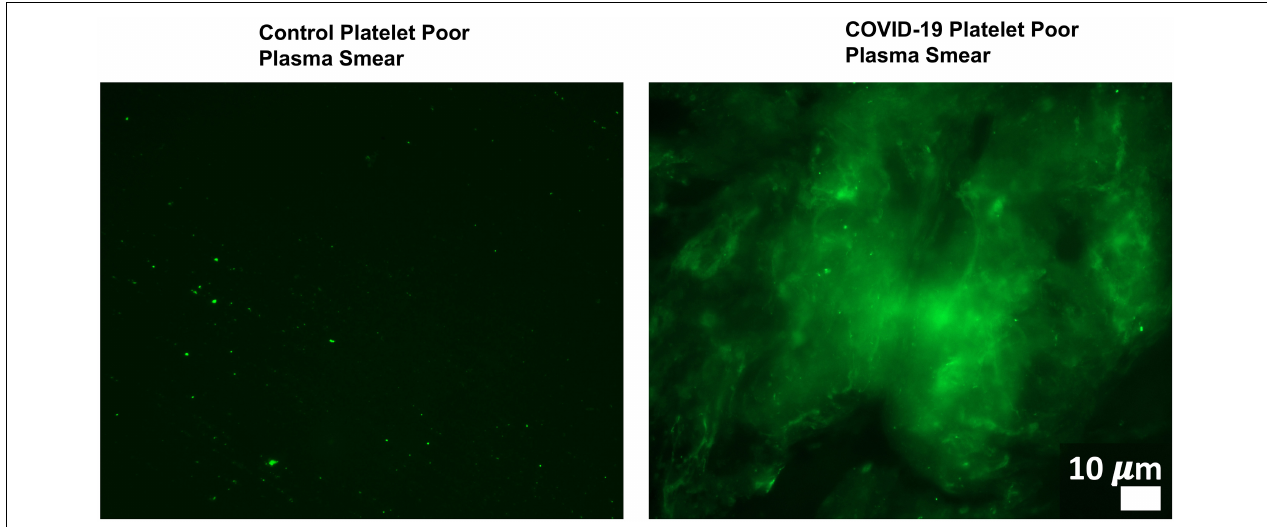
FIGURE 4 | Microclots are significantly increased in COVID-19 plasma as compared to controls. Fluorescence microscopy of COVID-19 and control platelet poor plasma incubated with the dye thioflavin (ThT), which detects spontaneously formed microclots. Original image courtesy of Dr. Resia Pretorius.